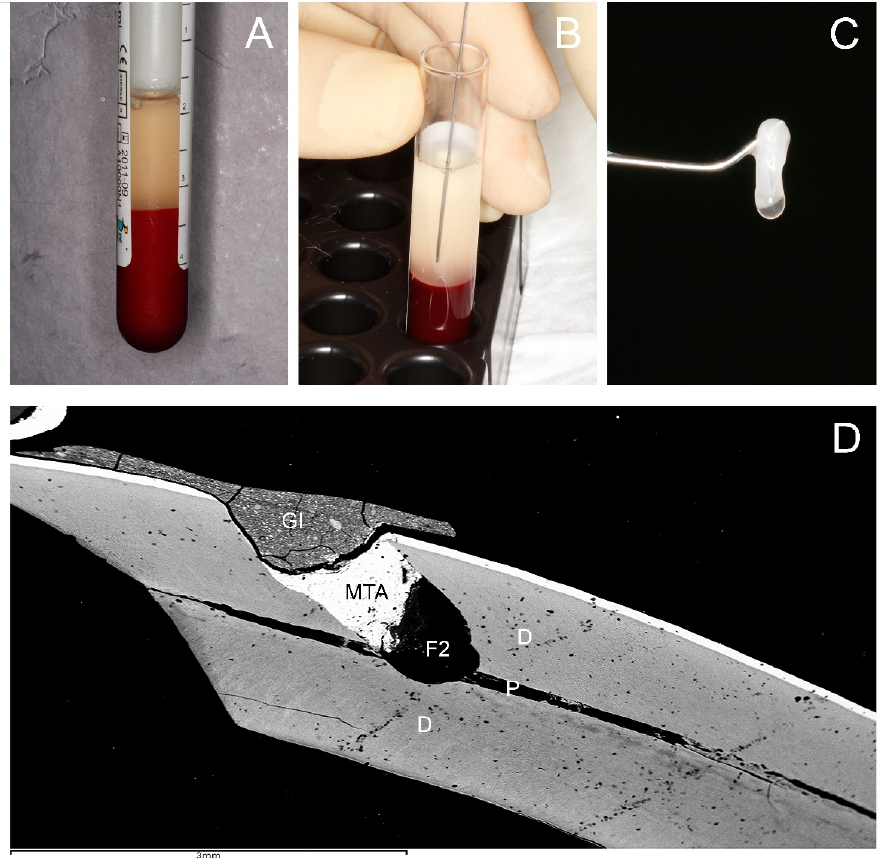
Figure 1. Obtention of the tridimensional clot of PRGF and a rabbit mandibular incisor with the